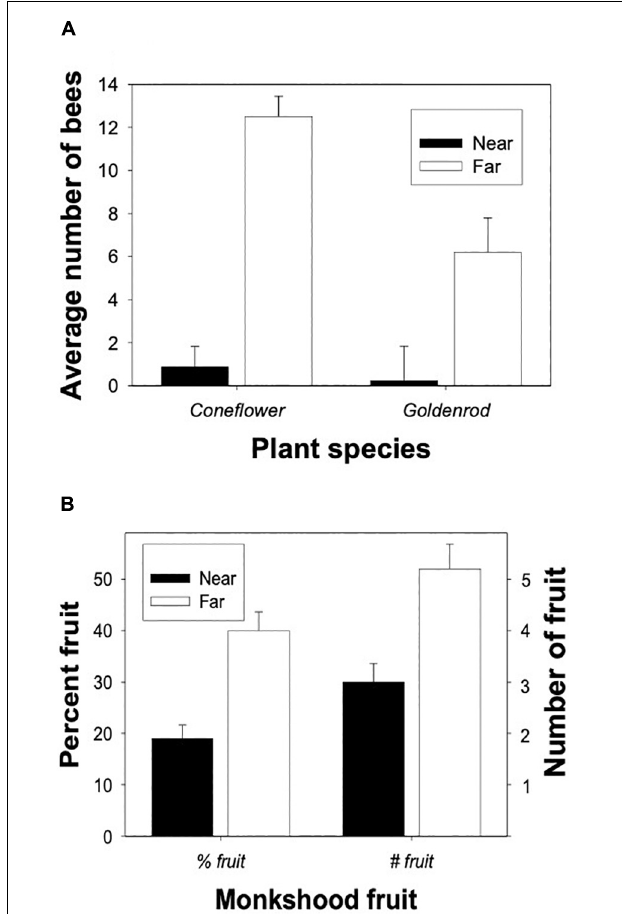
FIGURE 7 | (A) The mean ± SE number of bumble bees observed at six matched pairs of coneflower ( Rudbeckia occidentalis ) and goldenrod ( Solidago spp.) within 4 km and farther than 5 km from a large bumble bee wolf aggregation. (B) Fruit-set in the bumble bee pollinated flower, western monkshood ( Aconitum columbianum ), within 0.5 km and farther than 5 km from a large bumble bee wolf aggregation. Left bars: the percentage (mean ± SE) of marked monkshood flowers that produced fruits. Right bars: the total number (mean ± SE) of fruits on haphazardly chosen monkshood plants. Data from Dukas